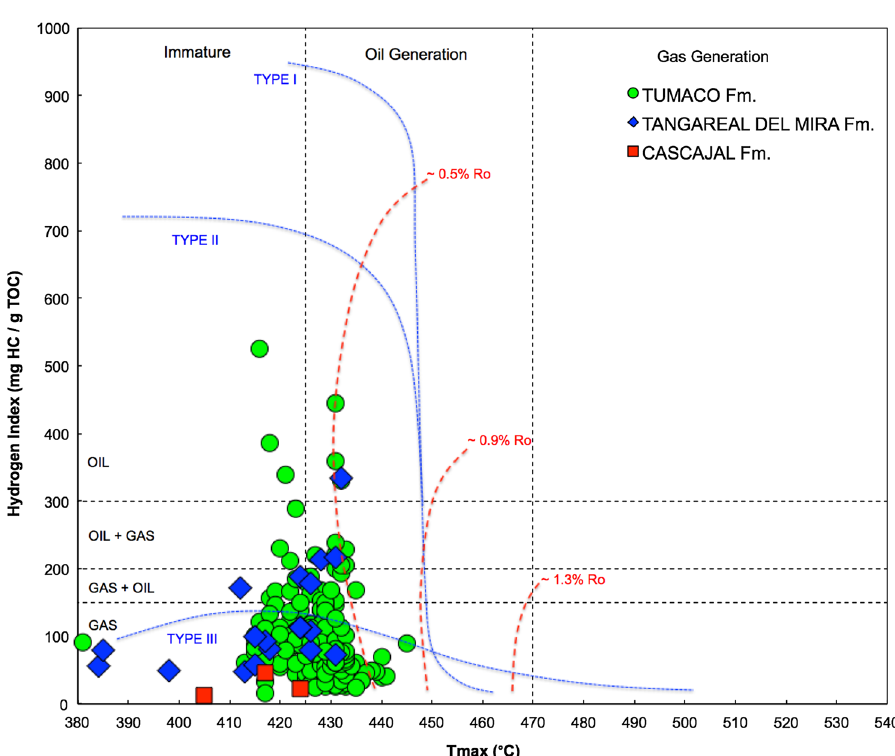
Fig. 4 Kerogen type and thermal maturity using HI (mg HC/g TOC) versus T max